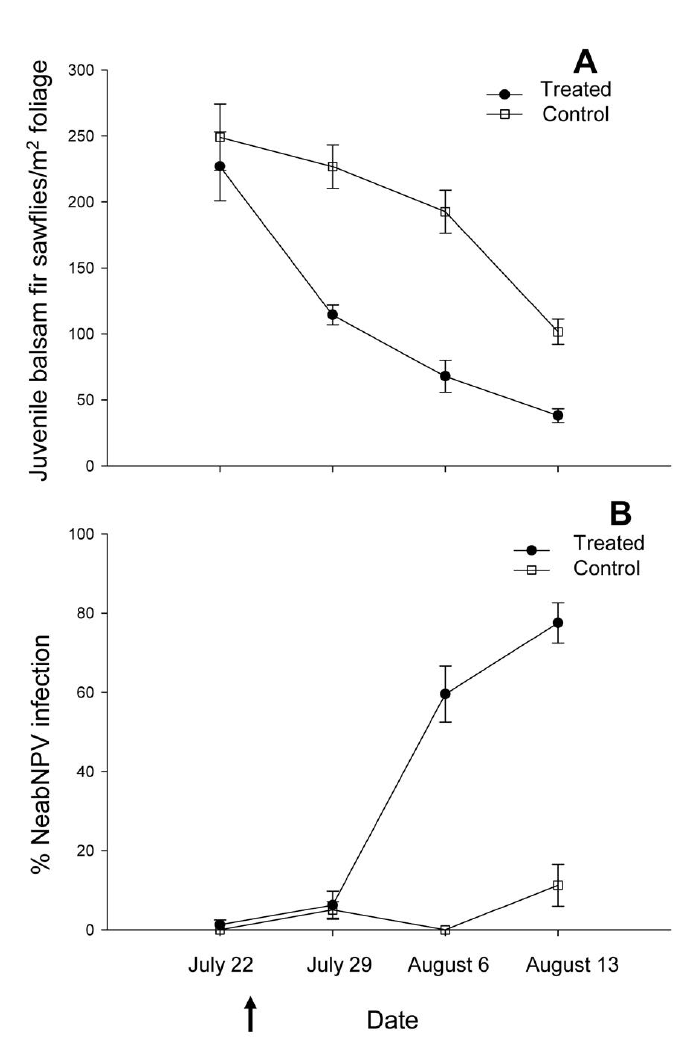
Figure 6. ( A ) Seasonal trends in the mean (±SE) densities of juvenile (larvae and pupae) balsam fir sawflies and ( B ) mean (±SE) prevalence of NeabNPV infection in juvenile sawfly populations adjacent to NeabNPV treatment (black circles) and untreated control (white square (cid:86)(cid:12)(cid:3)(cid:69)(cid:79)(cid:82)(cid:70)(cid:78)(cid:86)(cid:3)(cid:68)(cid:87)(cid:3)(cid:50)(cid:79)(cid:71)(cid:3)(cid:48)(cid:68)(cid:81)(cid:182)(cid:86)(cid:3)(cid:51)(cid:82)(cid:81)(cid:71)(cid:17)(cid:3)(cid:36)(cid:85)(cid:85)(cid:82)(cid:90)(cid:3)(cid:76)(cid:81)(cid:71)(cid:76)(cid:70)(cid:68)(cid:87)(cid:72)(cid:86)(cid:3)(cid:68)(cid:72)(cid:85)(cid:76)(cid:68)(cid:79)(cid:3)(cid:68)(cid:83)(cid:83)(cid:79)(cid:76)(cid:70)(cid:68)(cid:87)(cid:76)(cid:82)(cid:81)(cid:3)(cid:82)(cid:73)(cid:3)(cid:49)(cid:72)(cid:68)(cid:69)(cid:49) PV on 24 July